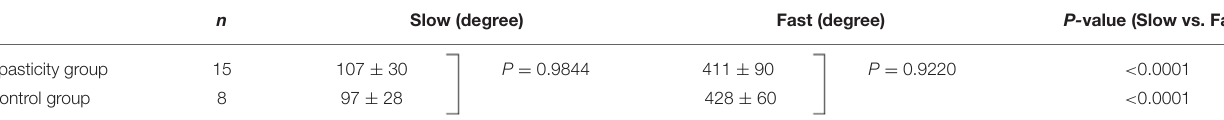
TABLE 2 | Angular velocity at Slow and Fast conditions.